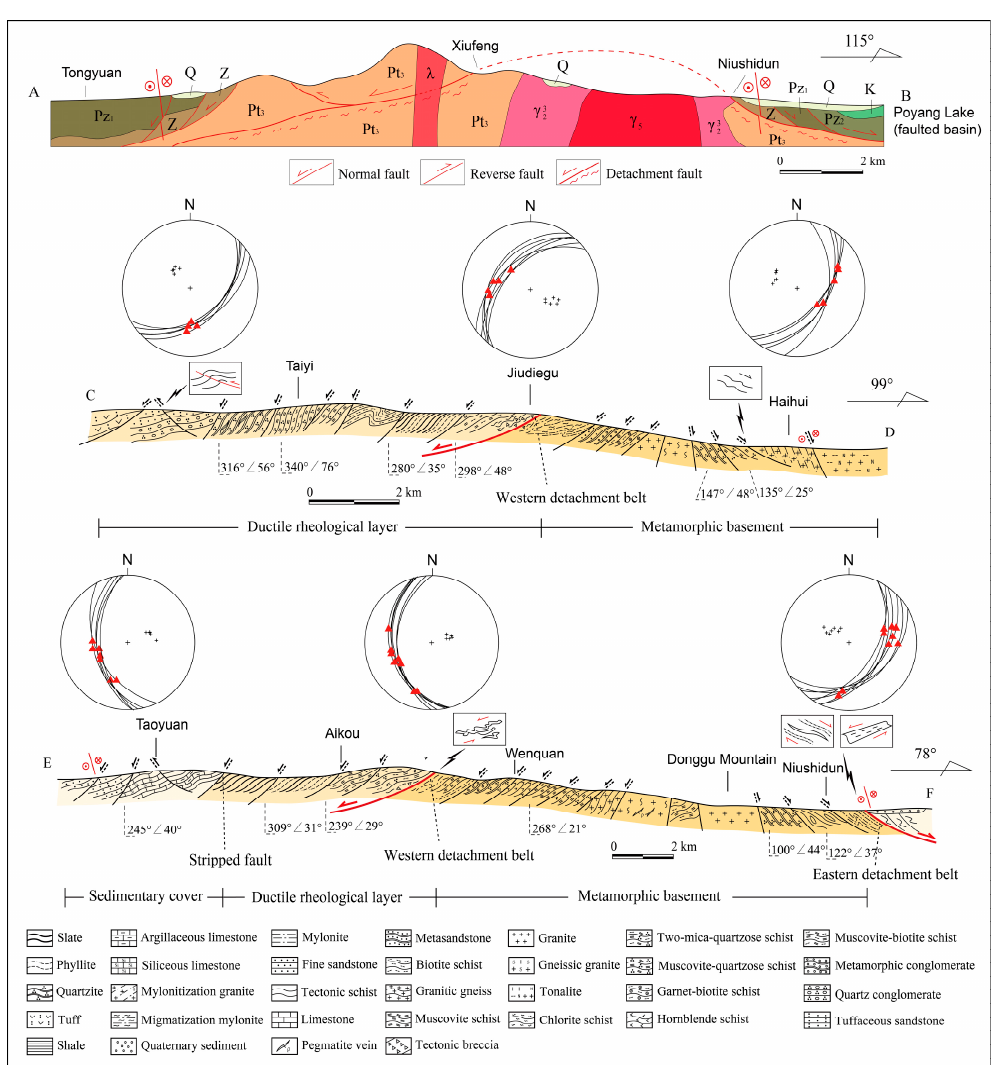
Figure 2. Transverse section (“A-B”) and tectonic sections in the north (“C-D”) and south (“E-F”) of the Lushan